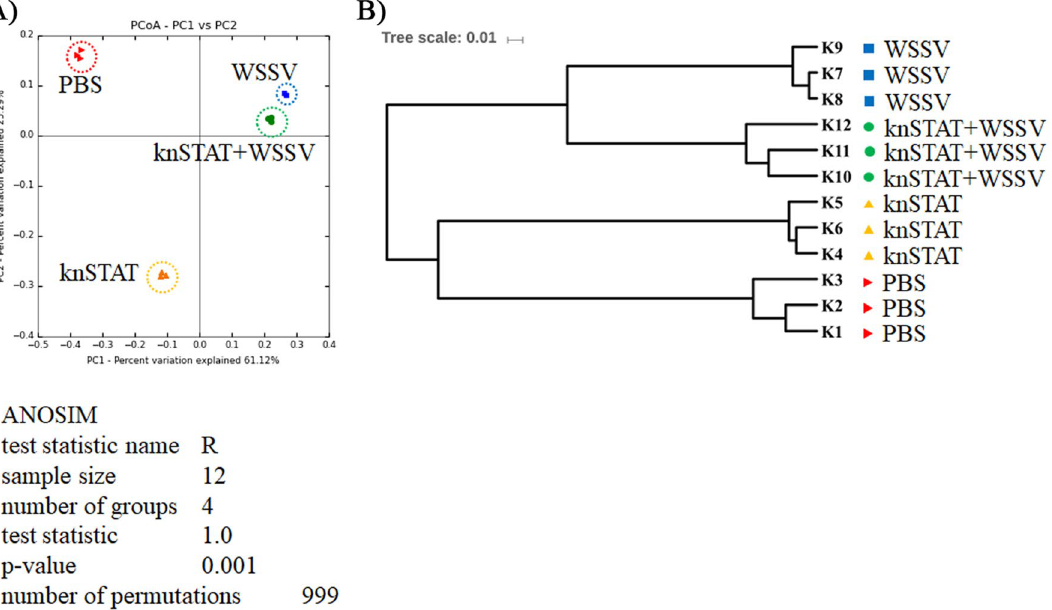
Figure 3. ( A ) Principal coordinate analysis (PCoA) based on unweighted UniFrac distance and ( B ) unweighted UPGMA clustering. The knSTAT refers to Pm STAT silencing